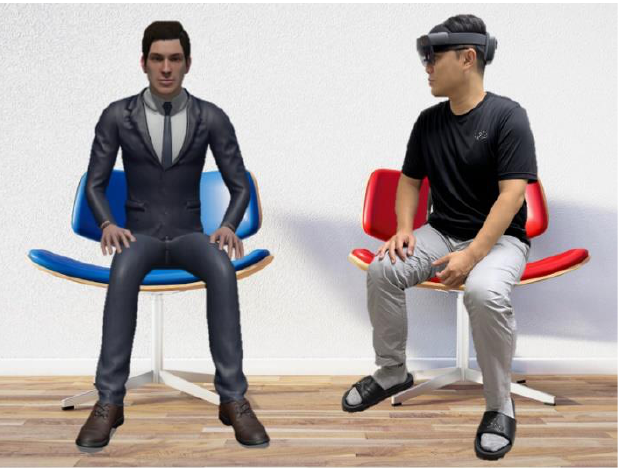
Figure 9. An example of our results that need to be made more automatic for gaze alignment.